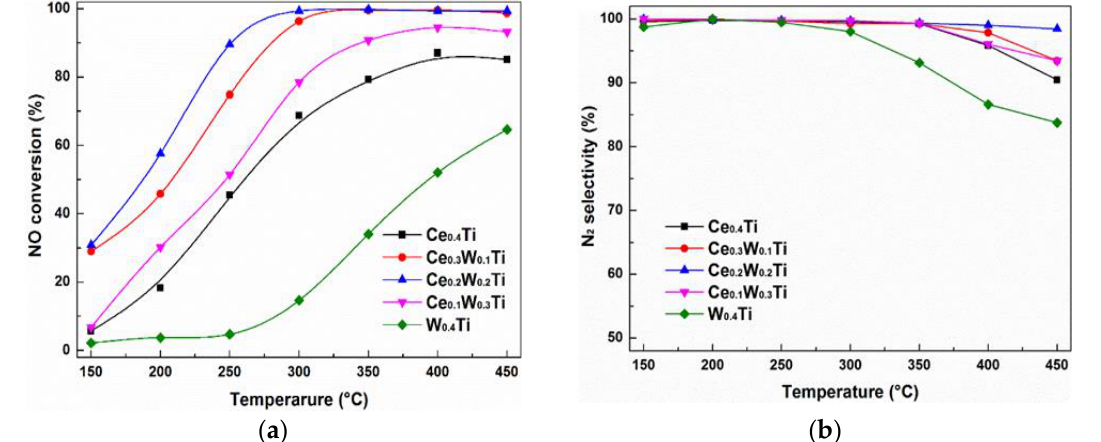
Figure 1. NO conversion ( a ) and N 2 selectivity ( b ) as a function of reaction temperature over the Ce-W-Ti catalysts. Reaction conditions: [NO] = [NH 3 ] = 500 ppm, [O 2 ] = 5%, balanced N 2 , GHSV = 120,000 mL·g − 1 ·h − 1 .